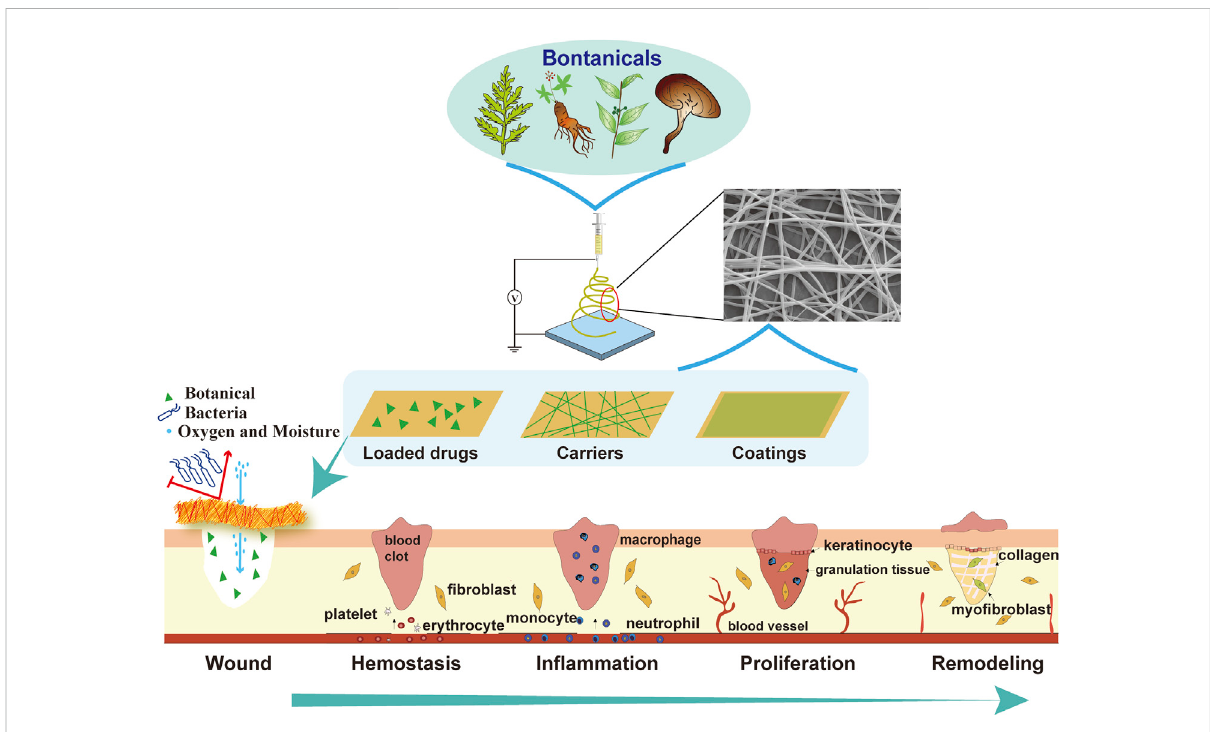
FIGURE 1 Electrospinningofbotanicalsforskinwoundhealing.Avarietyofbotanicalscanbeelectrospunaswounddressingsintheformofloadeddrugs, or carriers, or coatings, to provide a suitable microenvironment for different stages of wound healing, including hemostasis, in fl ammation, proliferation and